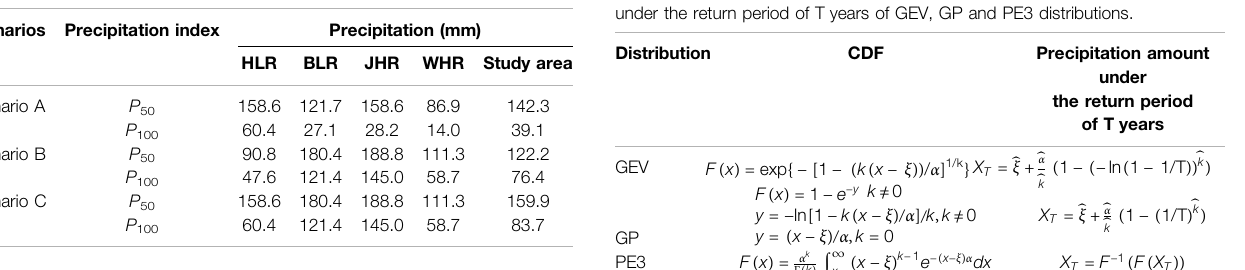
TABLE 1 | Precipitation in different scenarios in the study area. TABLE 2 | The cumulative distribution functions (CDF) and precipitation amount